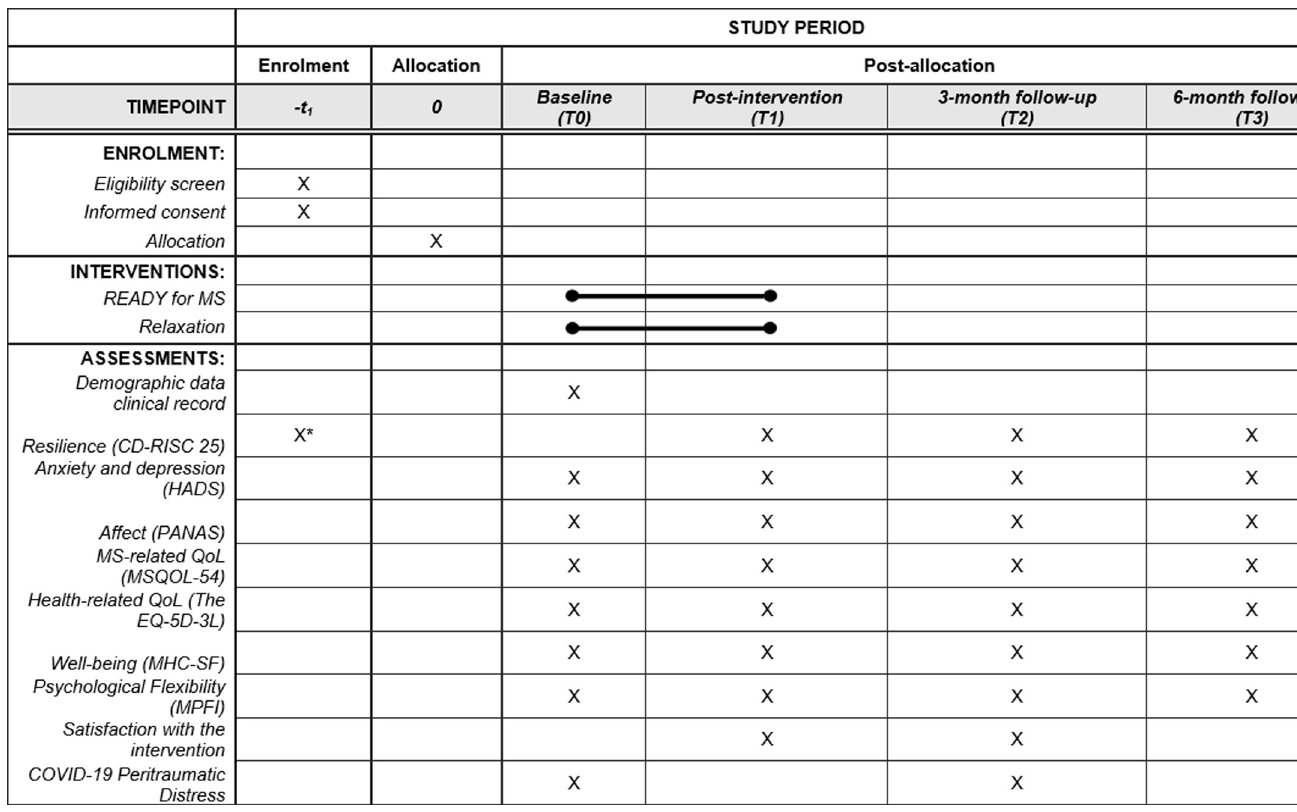
Fig 1. Schedule of enrolment, interventions and assessments. Note. � CD-RISC 25 is administered after informed consent is signed.